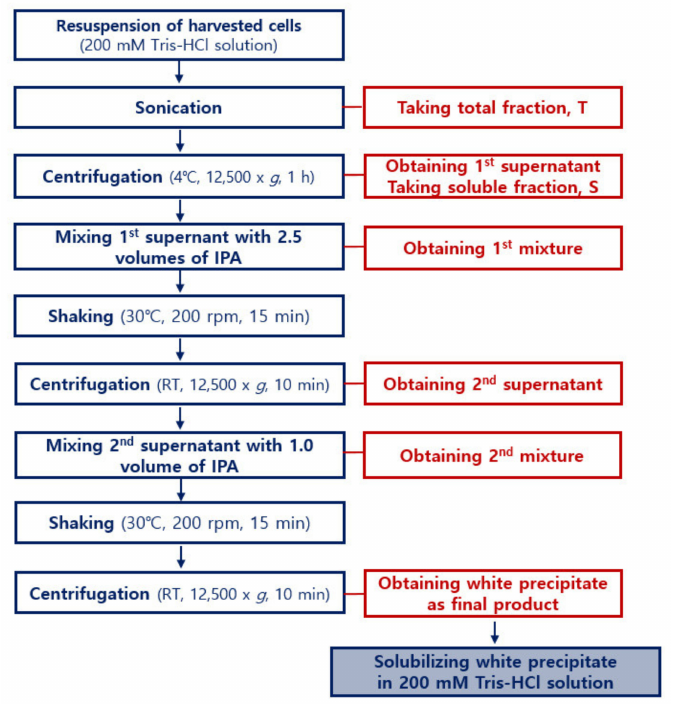
Figure 2. Detailed flowchart of the ATPS purification process for soluble recombinant hydrophobin DewA. This process was established by experimental modifications of known processes in the prior publications. The flowchart shows that the purification procedure uses only one reagent, that is,